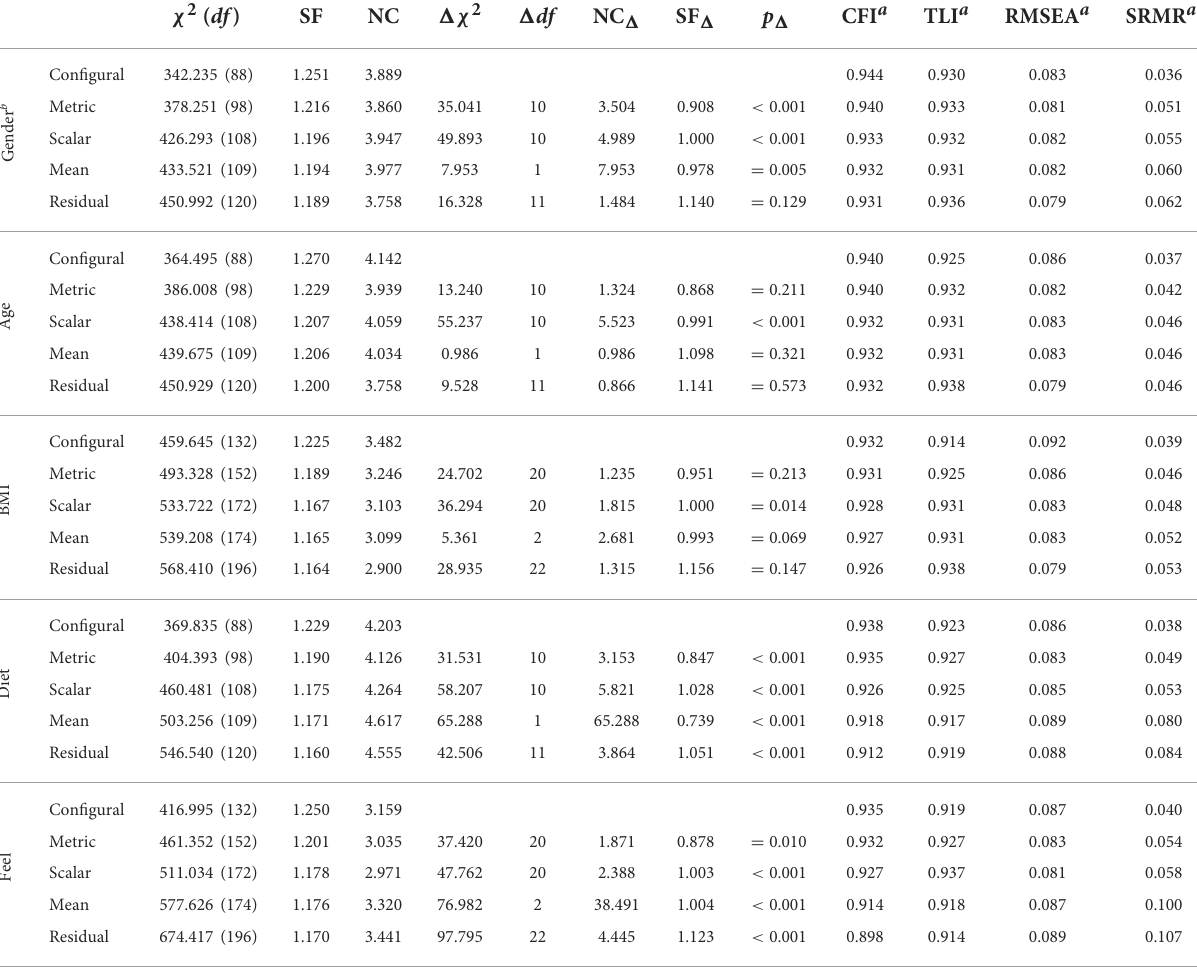
TABLE 4 Robust fit indices and Satorra-Bentler scaled χ 2 differences for multi-sample